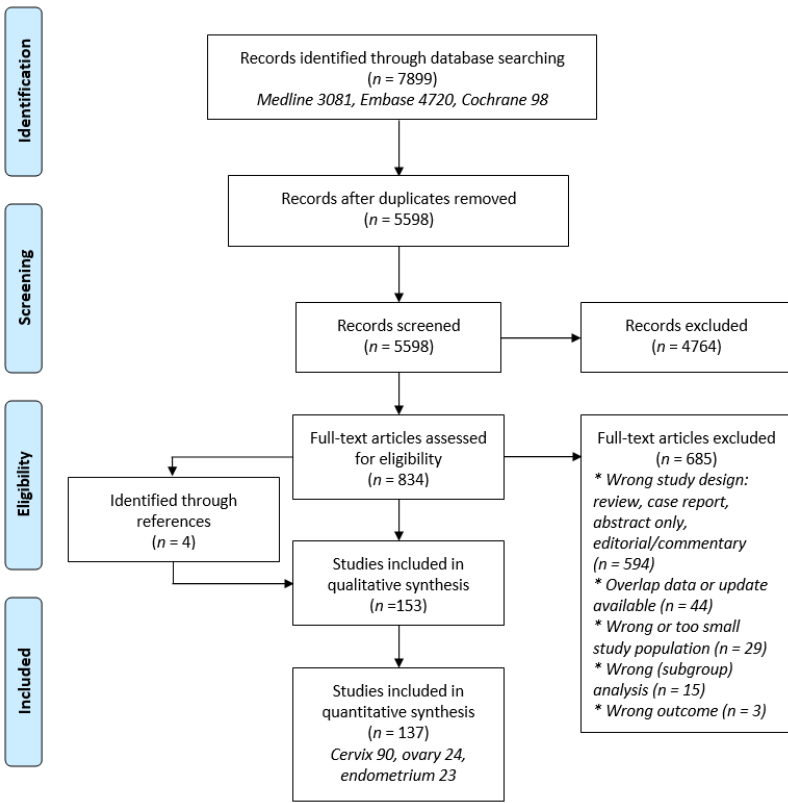
Figure 1. PRISMA flowchart summarizing the process for the identification of eligible articles.